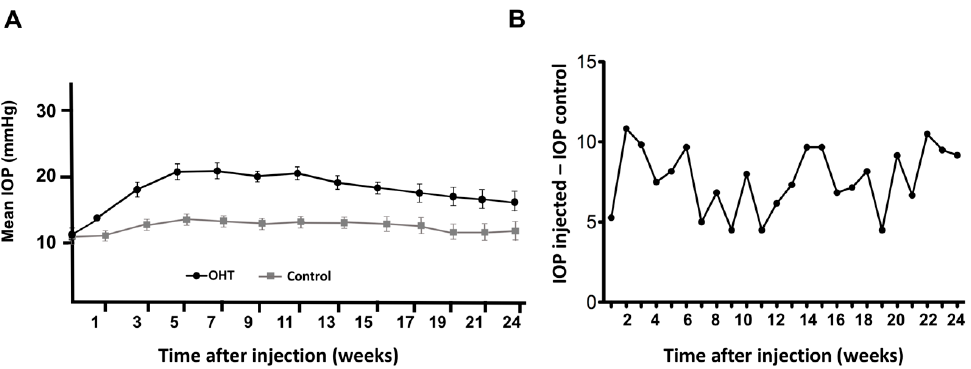
between IOP intervention eyes. ( B ) IOP di ff erence (IOP intervention - IOP control) for one illustrative animal monitored for 24